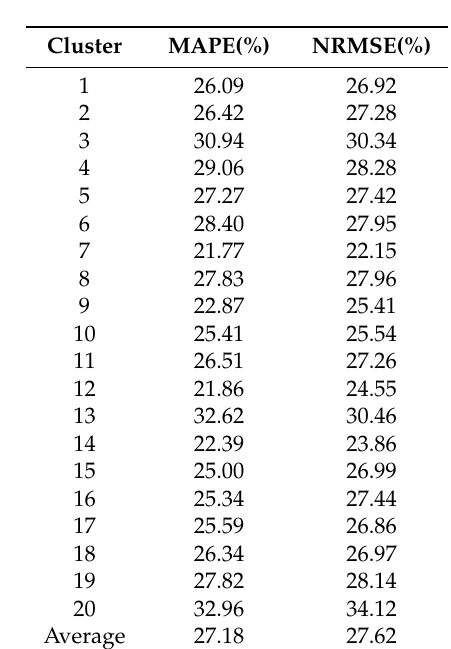
Table 1. Results from charging stations on Jeju island applying the EV charging electricity consumption regression model.